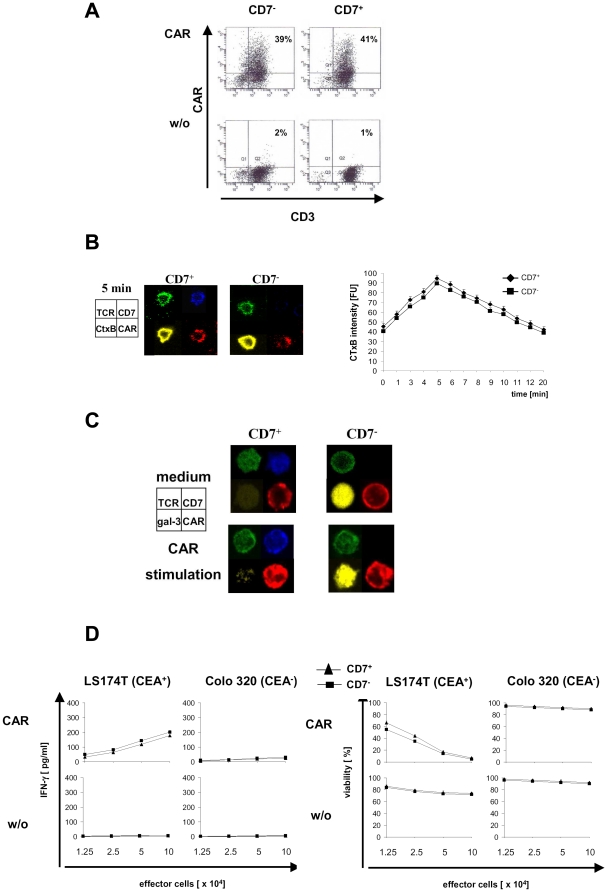
CAR triggered activation is as efficient in late-stage as in intermediate-stage T cells.(A) Isolated CD7− and CD7+ subset cells of CD8+ CD45RO+ T cells were engineered with the CEA-specific CAR BW431/26scFv-Fc-CD3-zeta by retroviral gene transfer. CAR expression was monitored by flow cytometry with a PE-conjugated anti-IgG1 mAb and a FITC-conjugated anti-CD3 mAb. Dot plots of one representative transduction of CD7− and CD7+ T cells from five independent experiments is shown (B) CAR modified T cells were activated for various time intervals (1 min until 20 min) on coverslips coated with the BW2064/36 mAb. The incubation was stopped with paraformaldehyde and cells were stained for TCR (green), CD7 (blue), CAR (red) and CtxB (yellow). Imaging after 5 min of activation is exemplarily shown. Synapse formation intensity (CTxB intensity) was quantified as described in Materials and Methods. (C) To monitor location of galectin-3 upon CAR-mediated activation, engineered CD7− and CD7+ T cells were activated by the BW2064/36 mAb or an isotype-matched control antibody of irrelevant specificity as described in (B). Cells were stained for TCR-alpha/beta(green), CD7 (blue), CAR (red) and for galectin-3 (yellow). Imaging after 5 min of T cell activation of one representative experiment out of five is exemplarily shown. (D) To monitor CAR-mediated effector functions, CAR engineered CD7− and CD7+ T cells in increasing numbers were co-incubated with CEA+ LS174T and CEA− Colo320 tumor cells, respectively. IFN-gamma in the culture supernatants after 48 hrs was monitored by ELISA. Viability of tumor cells was colorimetrically determined by XTT assay. Data in Fig. 4 represent the mean of five experiments ± SEM and were compared using a paired t-test. * p<0.05. FU: fluorescence unit.